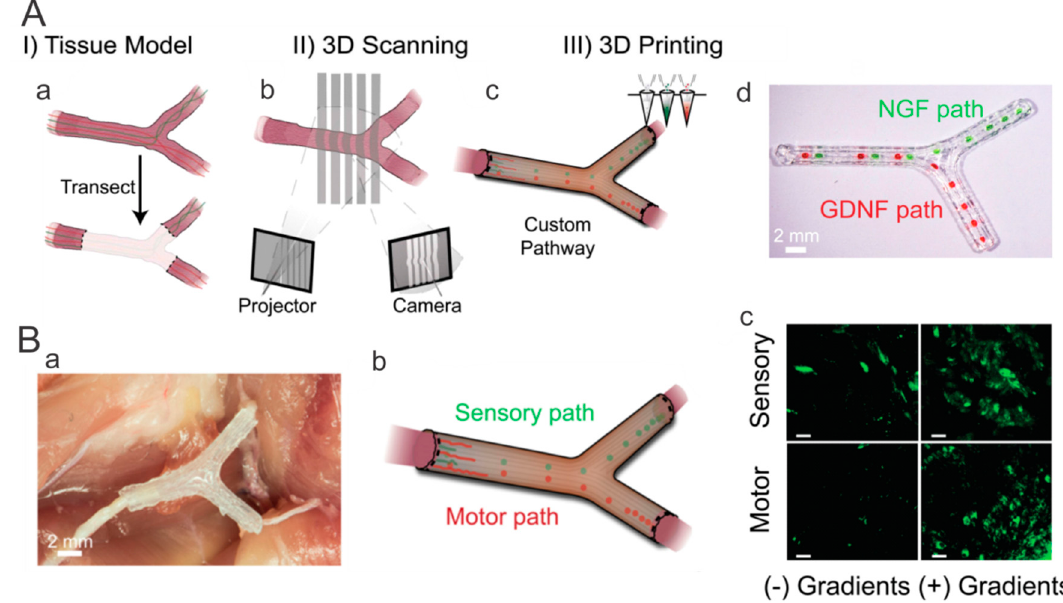
Figure 9. 3D printed hollow nerve pathway with spatial growth factors encouraged nerve regeneration. ( A ) Personalized nerve regeneration pathways produced by 3D scanning and printing: ( a ) the tissue model for subsequent imaging, ( b ) image of intact or transected tissue obtained by using structured light scanning, ( c ) the 3D printed nerve pathway, and ( d ) representative photograph of the 3D printed pathway with gradient patterns of NGF and GDNF. ( B ) In vivo study showing sensory and motor regeneration with the 3D printed nerve pathways: ( a ) photograph of an implanted 3D printed nerve pathway, ( b ) schematic of hollow gradient nerve pathway for bifurcation into sensory and motor nerve paths, and ( c ) histology of regenerated sensory and motor nerves stained for tubulin (green). Reprinted from Reference [72].